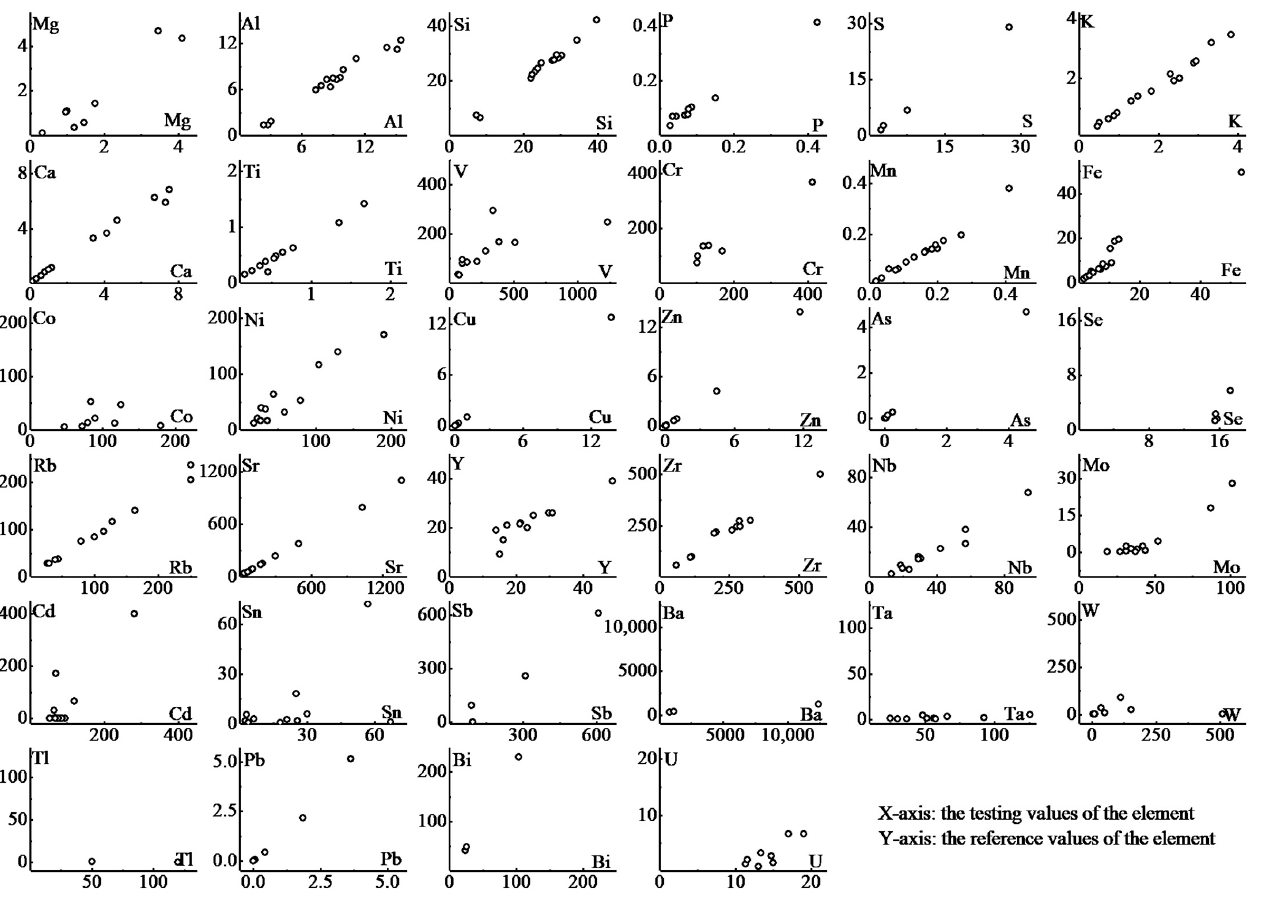
Figure 1. Scatter plots of testing values vs. reference values of the detected elements. The unit of Mg, Al, Si, P, S, K, Ca, Ti, Mn, Fe, Cu, Zn, As and Pb was 10 − 2 , and that of V, Cr, Co, Ni, Se, Rb, Sr, Y, Zr, Nb, Mo, Cd, Sn, Sb, Ba, Ta, W, Tl, Bi and U was 10 − 6 . Table 2. Correction indicators for elements to be tested by pXRF